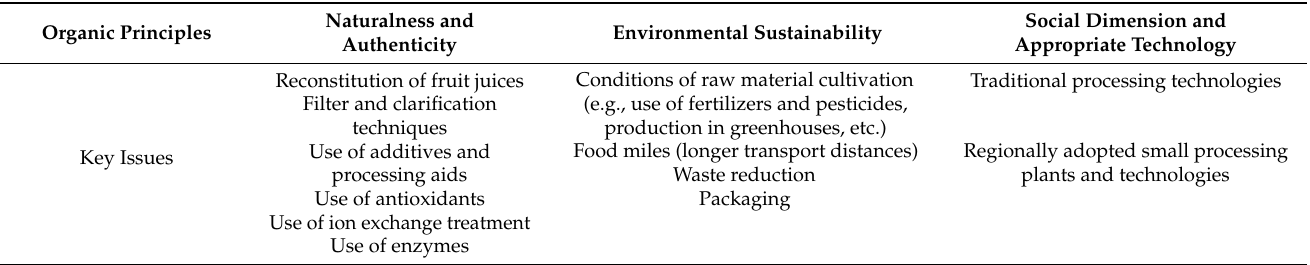
Table 1. Overview of key issues from the field of juice processing with relevance to the organic principles.